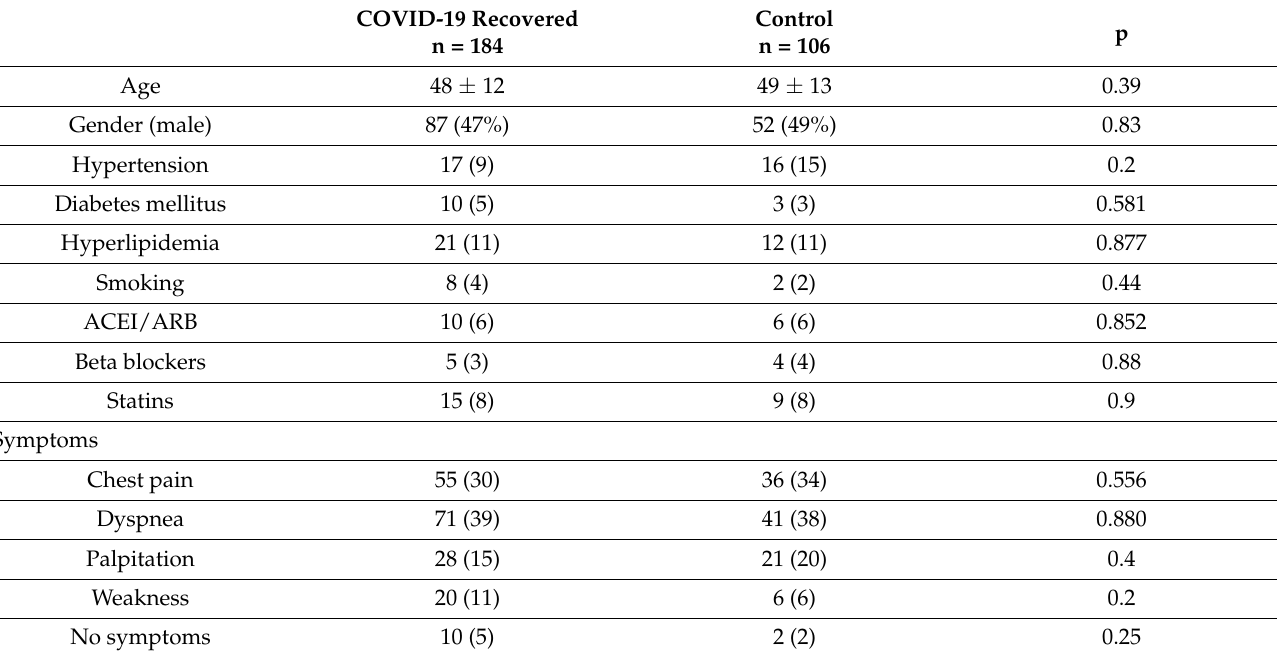
Table 1. Patient baseline